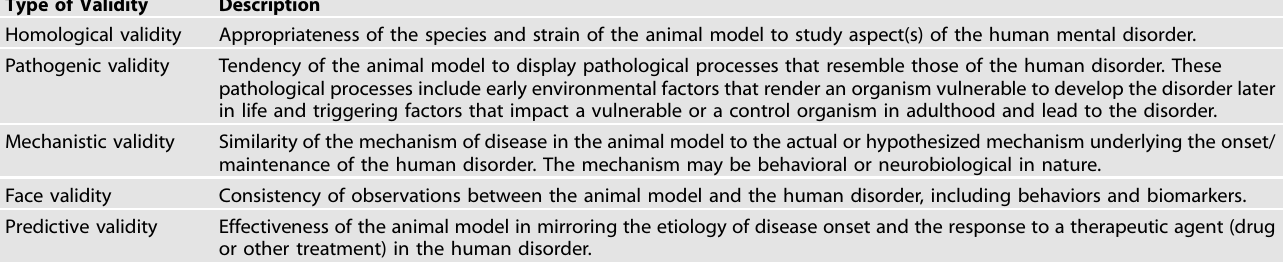
Table 2. Major categories of validity relevant to the assessment of animal models of BD.